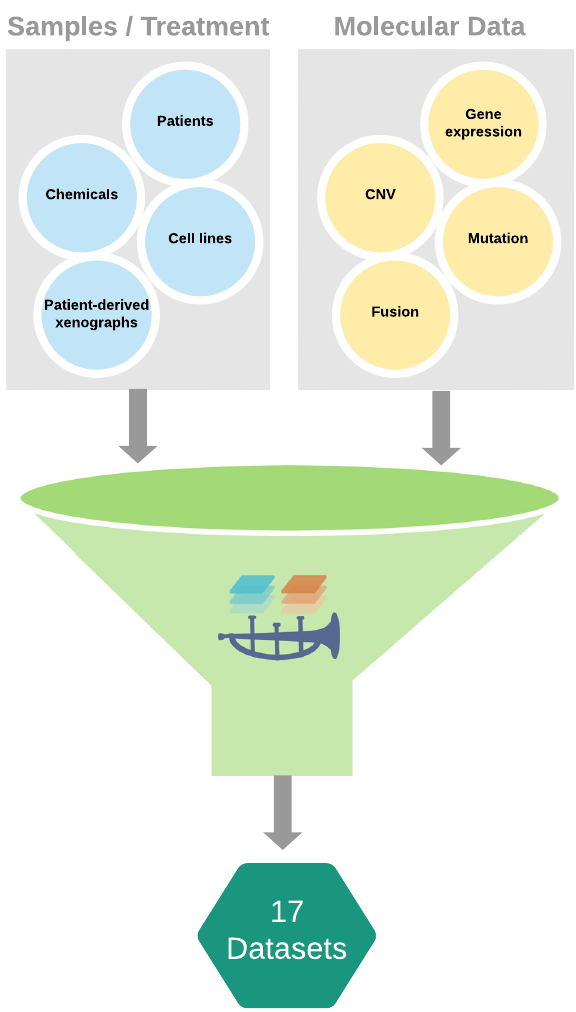
Fig. 1 Summary of samples, treatments, and molecular pro fi les utilized for data-object generation in ORCESTRA. Molecular data, sample, and treatment information are combined to yield 17 unique data objects from a variety of biomedical data